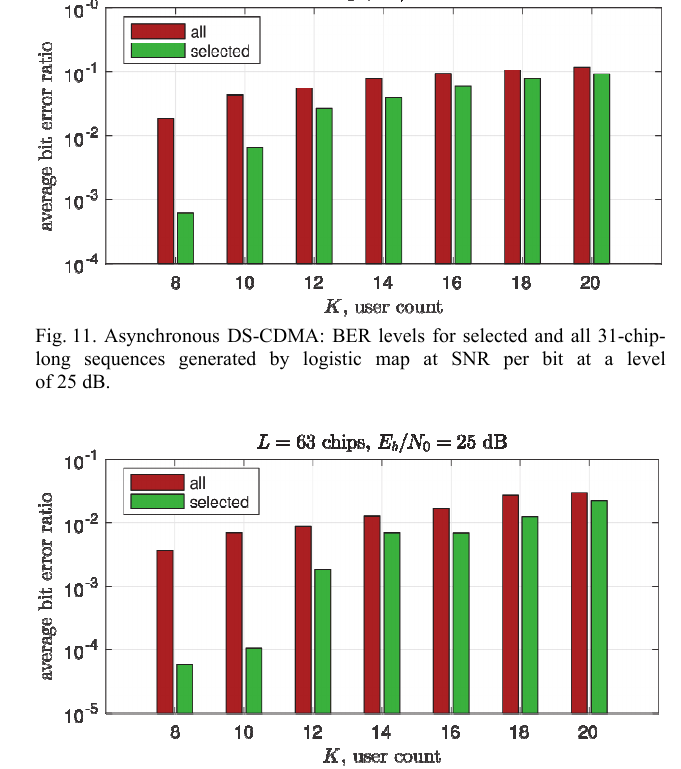
Fig. 12. Asynchronous DS-CDMA: BER levels for selected and all 63-chip- long sequences generated by logistic map at SNR per bit at a level of 25 dB.